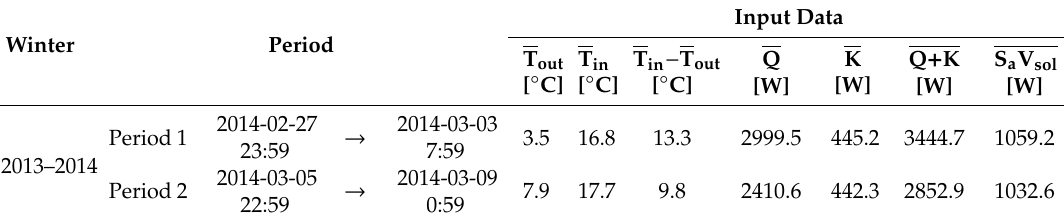
Table 7. Necessary period averaged variable values to estimate the HLC simple (simple Heat Loss Coe ffi cient) and HLC (Heat Loss Coe ffi cient) for Loughborough. The variables included are the outdoor temperature (T out ), the indoor temperature (T in ), the temperature di ff erence (T in - T out ), the space heating heat input (Q), total electricity consumption, including synthetic occupants’ generation (K), the internal heat gains (Q + K) and the solar gains (S a V sol ).